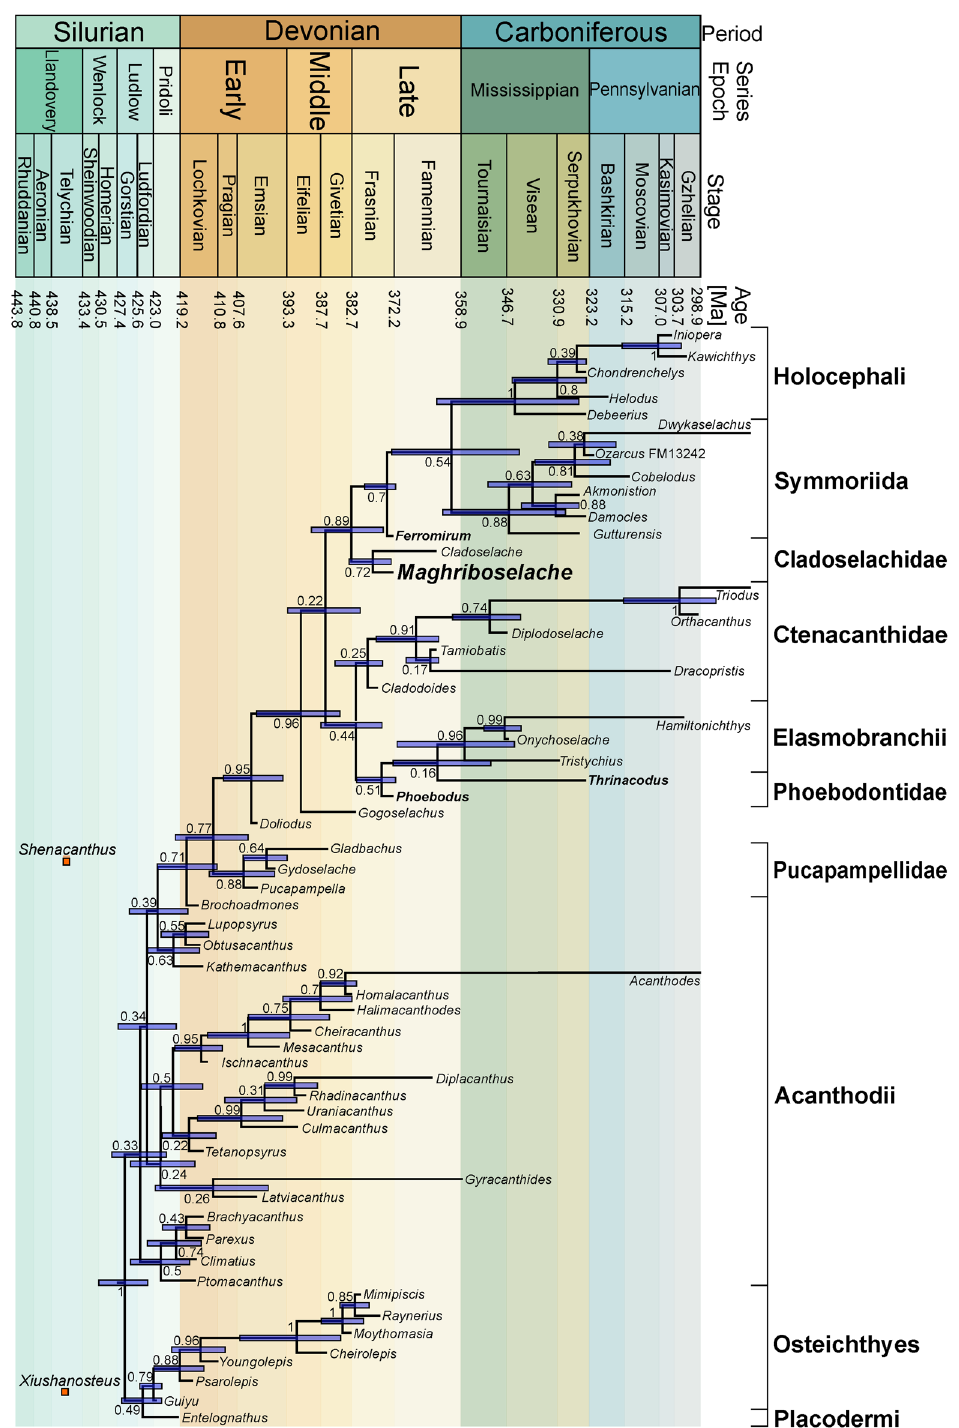
Fig. 13 Phylogeny based on the emended character matrix from Coates et al. (2017) and Frey et al., (2020a, b) . Bayesian tip-dating analyses of 230 characters were performed using the fossilized birth–death model. Early Silurian species after Zhu et al.